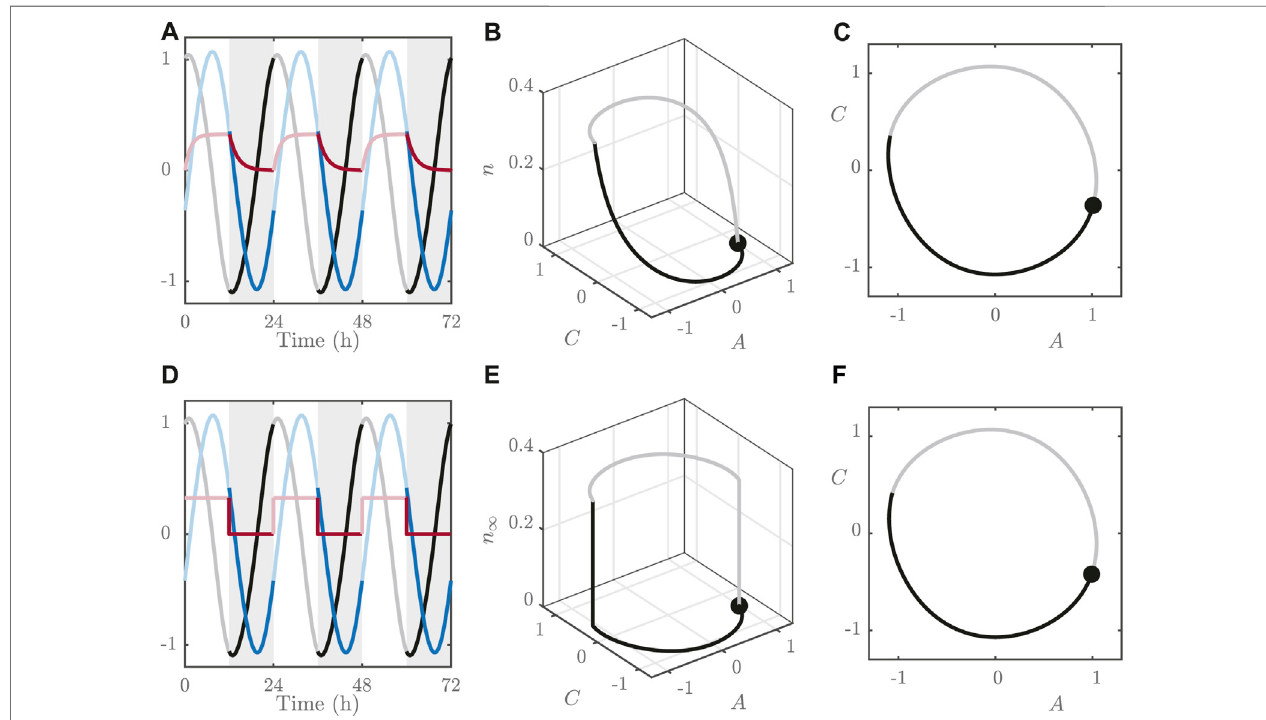
FIGURE 1 | (A – C) : Simulations of the FJK model Eqs 1 – 5 for N (cid:1) 12, τ c (cid:1) 24 . 2 with I (cid:1) 50. (D – F) : Simulations of the 2D version of the FJK model using ( Eq. 8 ) in placeof ( Eq. 4 ). (A) + (D) : Timeseriesof A (black), C (blue), and n (red). The shaded regions indicate where f ( t ) (cid:1) 0, whereas f ( t ) (cid:1) 1 in the unshaded regions. (B) + (E) : Stableentrained limit cycle.Thedarkportion oftheorbit corresponds totheintervalinwhich f ( t ) (cid:1) 0.Themarkershowsthepoint alongtheorbitwhere f changesfrom0 to 1. (C) + (F) : Projection of panels (B, E) , respectively, into the ( A , C ) plane.